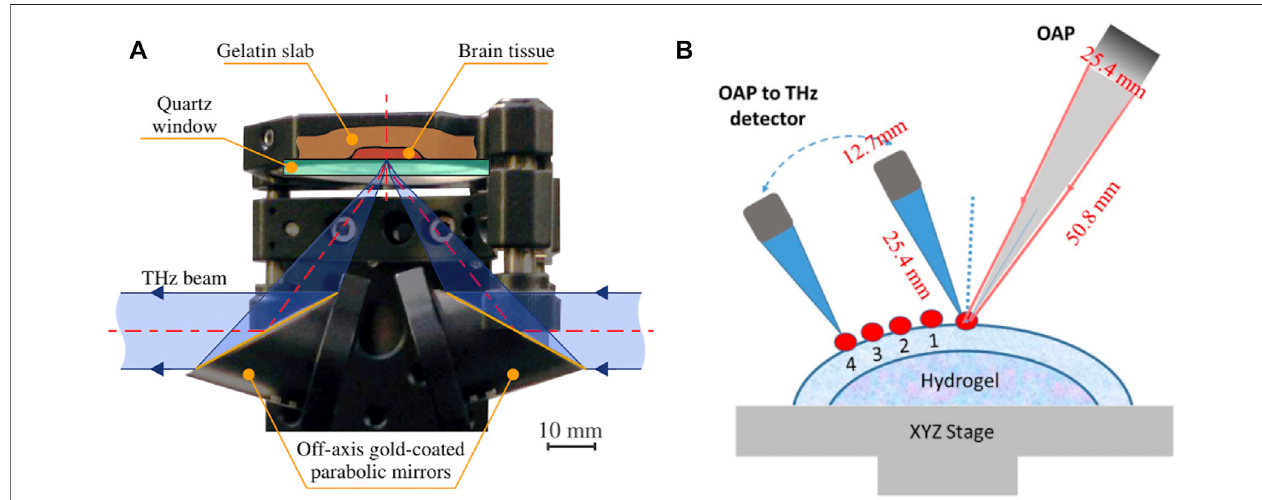
FIGURE 4 | (A) Re fl ection-mode terahertz spectroscopy unit for measuring gelatin-embedded human brain gliomas, based on an off-axis gold-coated parabolic mirrorand areferencewindowontopofwhichtissuesamplesareplaced[57].ReproducedunderaCreativeCommonsAttribution4.0Unported License.©2019SPIE. (B) The process of acquiring THz signals from the corneal surface and corneal subsurface [78]. Reproduced under a Creative Commons Attribution 4.0 Unported License.©2021SPIE.Afteracquiringthewaveformonceatanincidentangleof30 ° ,aseriesofre fl ected beamswereconsecutivelyacquired atdifferentdistances (multiple points with a spacing of 2 mm) away from the direct re fl